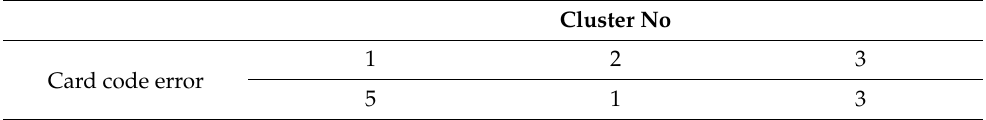
Table 3. Clustering of variable of token error (source: research